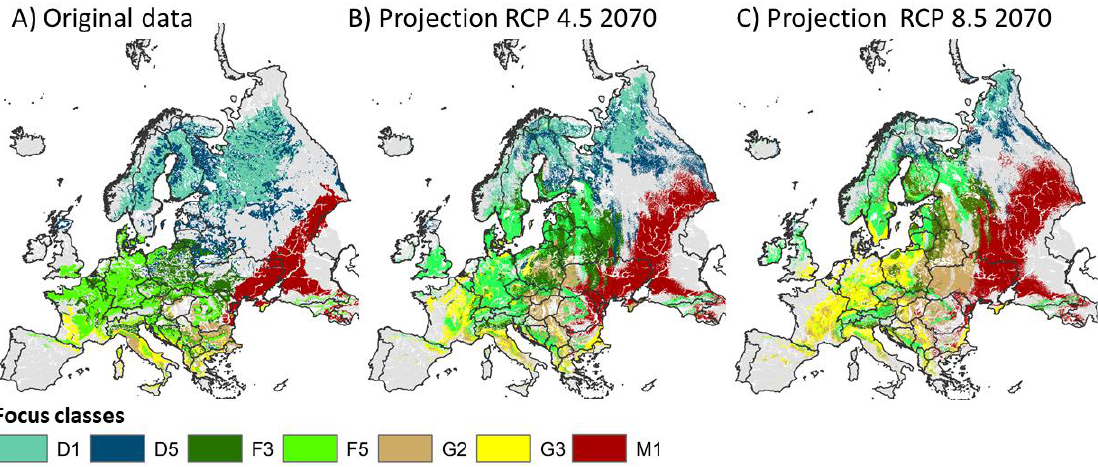
Figure 5. Shift in vegetation potentials of prevalent CaPV classes: Western boreal Picea forests (D1) ‘petrol areas’; boreal and hemiboreal Pinus forests (D5) ‘dark-blue areas’; mixed Quercus-Carpinus forests (F3) ‘dark-green areas’; Fagus and mixed Fagus forests (F5) ‘bright-green areas’; sub-Mediterranean-subcontinental thermophilous Q. cerris and Q. frainetto forests (G2) ‘light-brown areas’; sub-Mediterranean and meso-supra-Mediterranean Q. pubescens forests (G3) ‘yellow areas’ and true steppes (M1) ‘dark-red areas’; ( A ) Original data (zonal vegetation of map of Europe (Bohn et al. 2000)); ( B ) projection for RCP 4.5 and ( C ) projection for RCP 8.5 for the time slice 2061 – 2080 (2070).